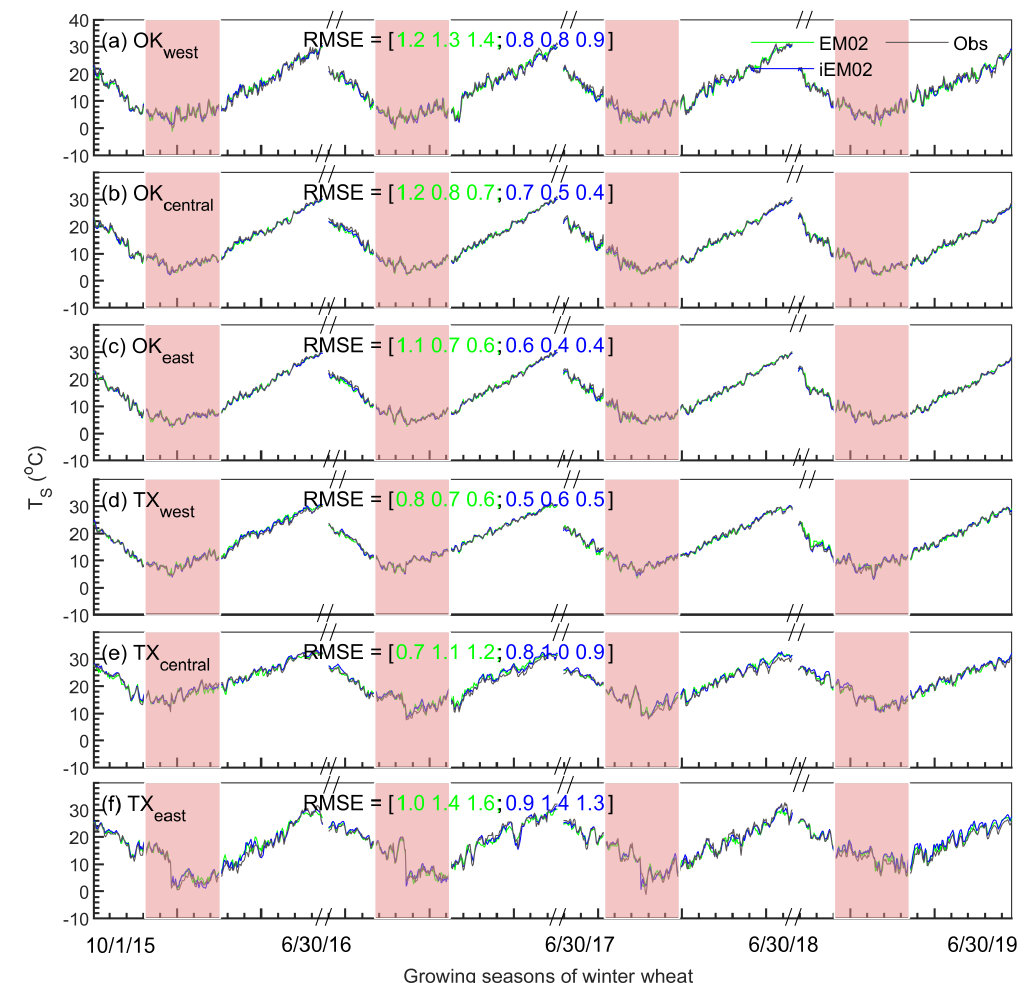
Figure 9. The same as Fig. 8 but for western, central, and eastern Oklahoma (a–c) and Texas (d–f)